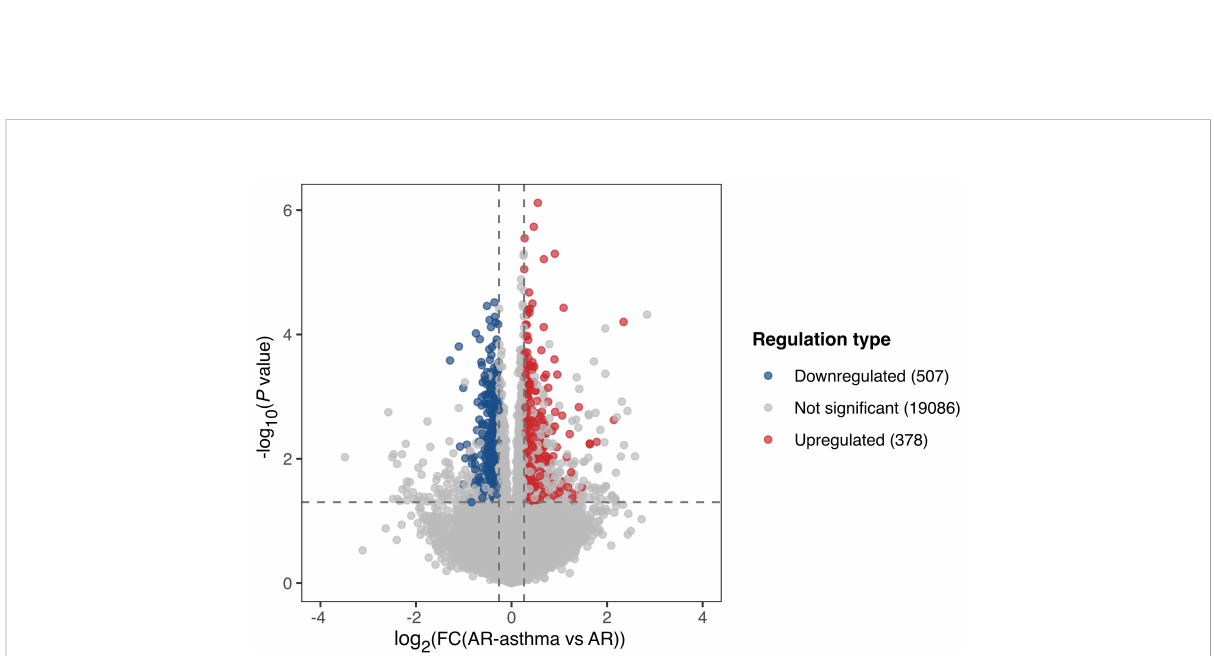
FIGURE 3 Volcano plot showing DEGs of the AR-asthma group compared to the AR group outside the pollen season. Signi fi cantly up- and down- regulated genes (|fold change| ≥ 1.2, P value < 0.05 and average FPKM, fragments per kilobase of transcript per million fragments mapped ≥ 1) were labeled as red and blue dots, respectively. AR, allergic rhinitis; DEGs, differentially expressed genes; FC, fold change.